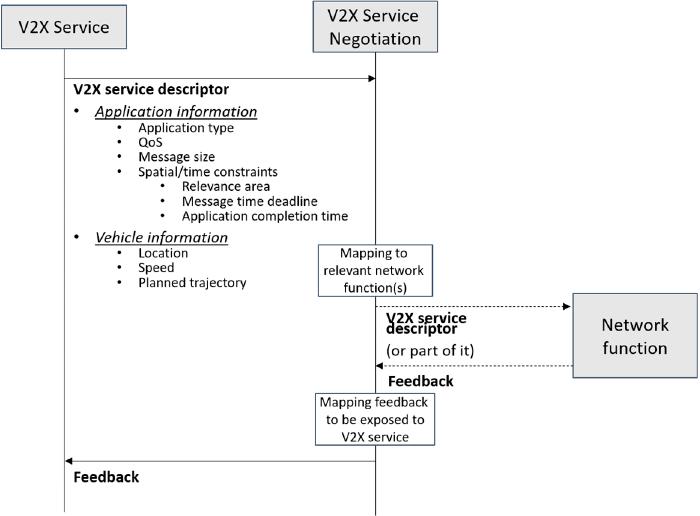
Figure 6. Flow diagram and information exchanged for the vehicle-to-everything (V2X) service Figure negotiation.